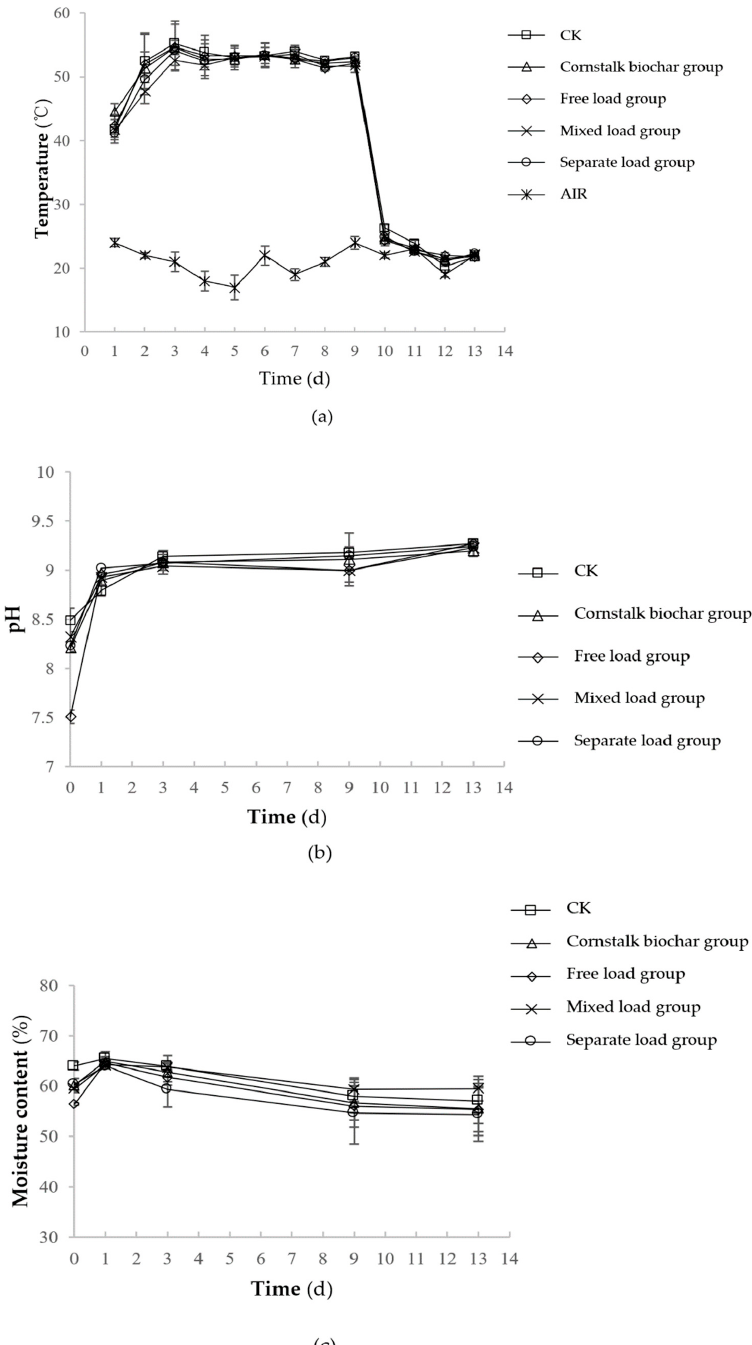
Figure 2. Evaluation of the temperature ( a ), pH ( b ) and moisture content ( c ) profile of different load methods during composting (CK: as the control); Note: Values are based on wet weight, and error bars represent the standard deviation ( n = 3).